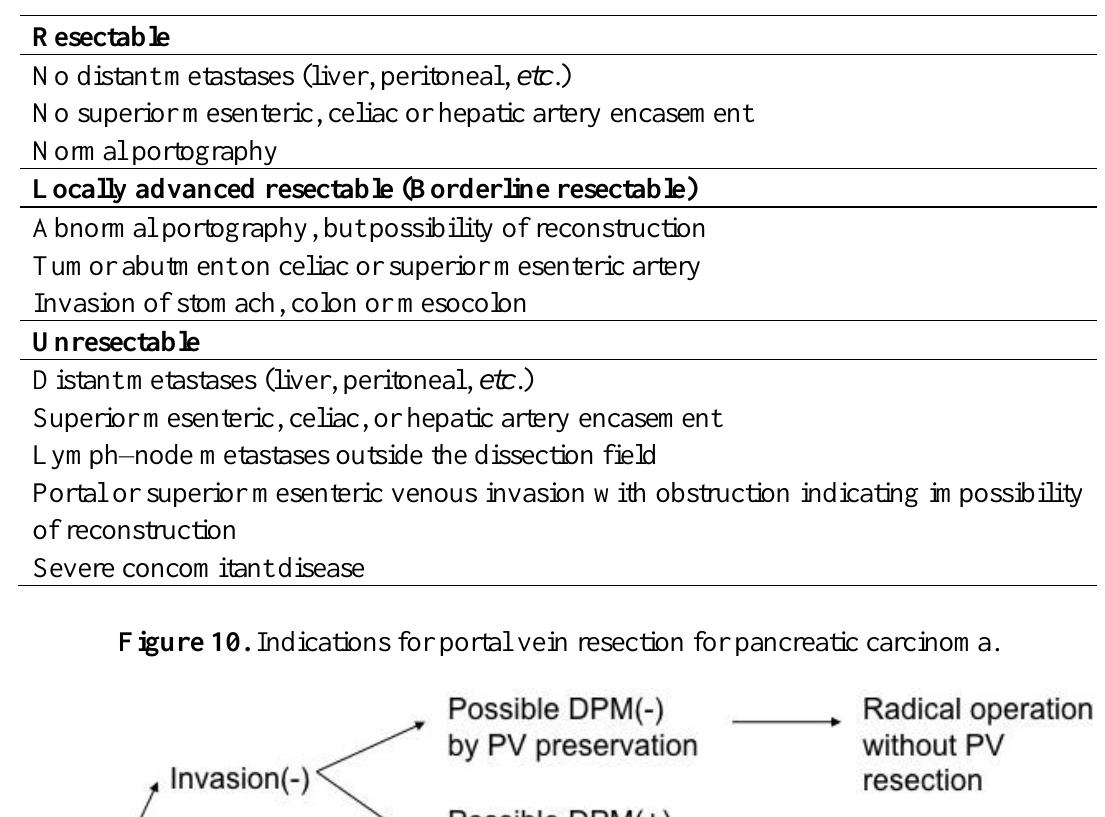
Table 1. Criteria for resectability (from [19]).